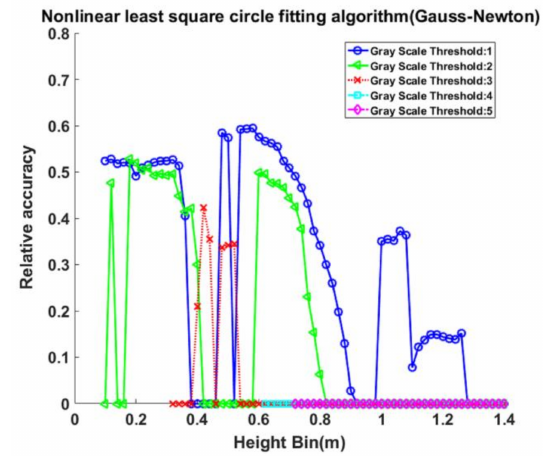
Figure 14. The relative accuracy of nonlinear least square circle fitting algorithm (Gauss-Newton) under different height bins and gray scale thresholds in single-scan mode of the natural secondary